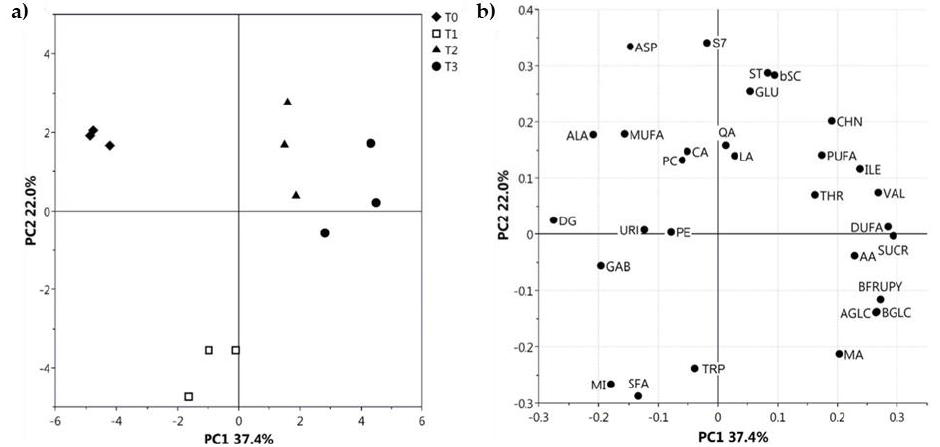
Figure 1. ( a ) PCA score ( b ) and loading plots of metabolite profiles (30 metabolites/metabolite classes) obtained from NMR data related to hydroalcoholic and organic extracts of kiwifruit at different postharvest stages (T0–T3). Results associated with malic acid (MA), citric acid (CA), ascorbic acid (AA), lactic acid (LA), quinic acid (QA), α - and β -glucose (AGLC and BGLC), su- crose (SUCR), β -fructopyranose (BFRUPY), Ala, Thr, Glu, Asp, Val, Ile, Trp and γ -aminobutyric acid (GAB), choline (CHN), uridine (URI), myo-inositol (MI), phosphatidylcholine (PC), phos- phatidylethanolamine (PE), digalactosyl diacylglycerol (DG), stigmast-7-en-3 β -ol (S7), stigmasterol (ST), poly-unsaturated fatty acids (PUFA), di-unsaturated fatty acids (DUFA), mono-unsaturated fatty acids (MUFA), saturated fatty acids (SFA), and β -sitosterol plus campesterol (bSC) are shown (Reprinted from [18] with permission from